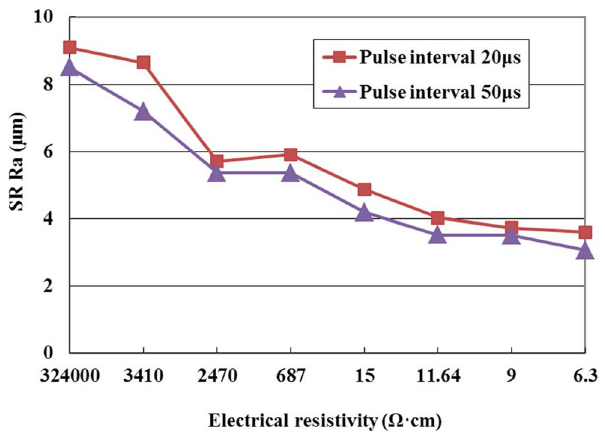
Figure 10. Effect of the pulse interval on SR.